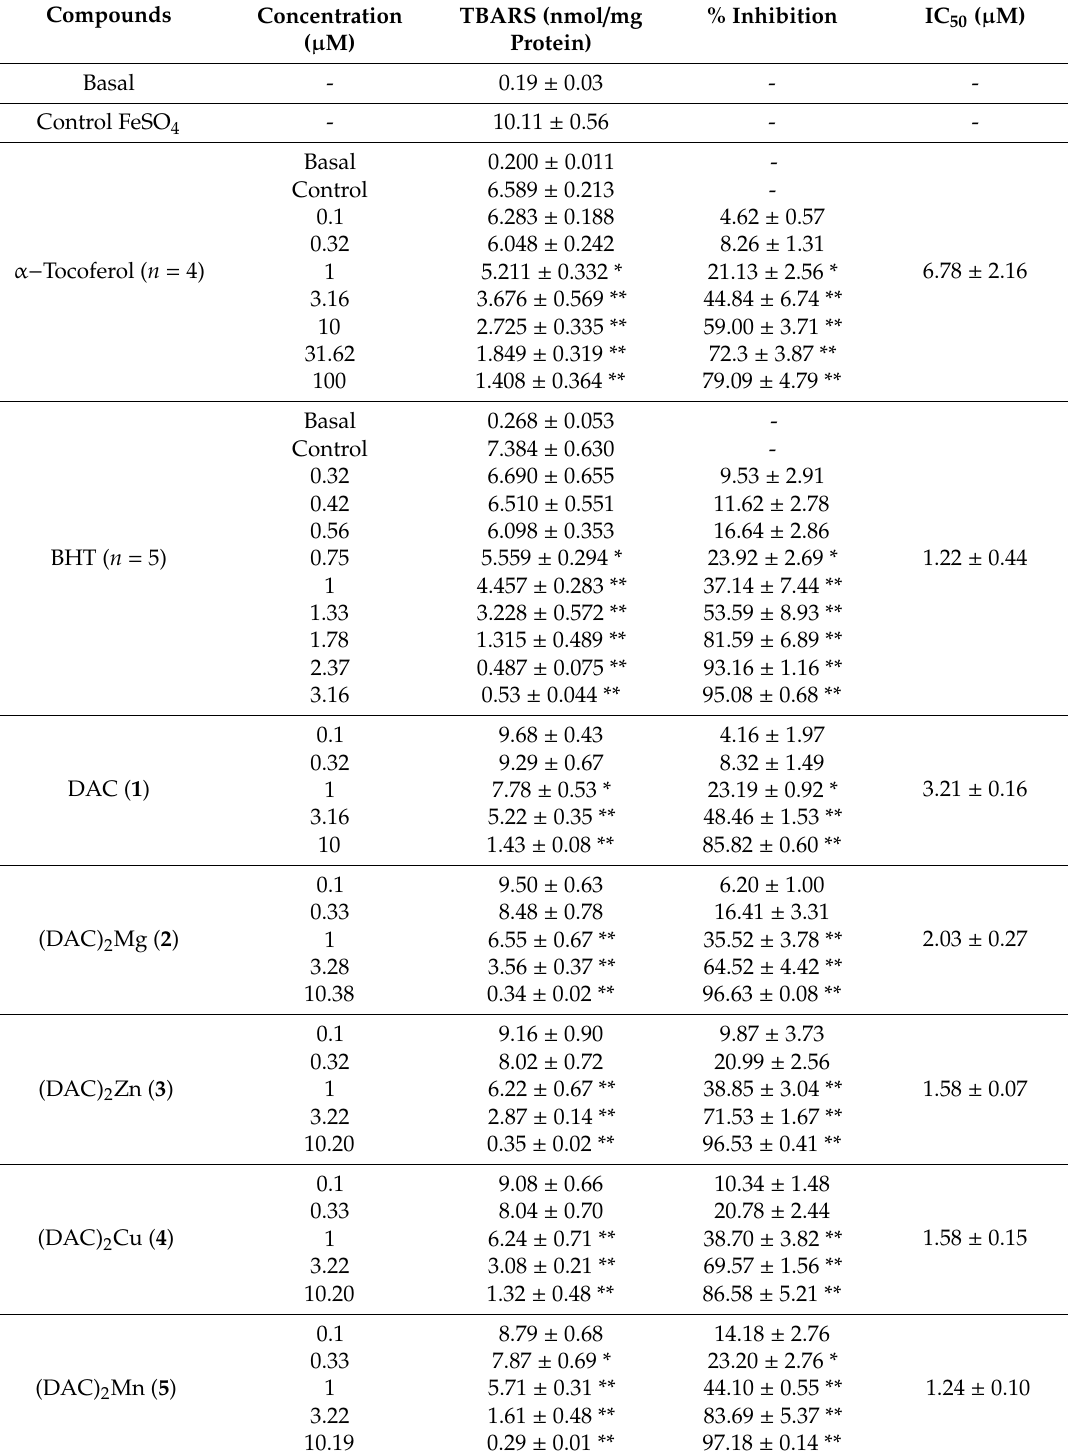
Table 8. IC 50 of inhibition of lipid peroxidation of compounds 1 , 2 , 3 , 4, and 5 . Compounds Concentration TBARS (nmol / mg % Inhibition IC 50 ( µ M) ( µ M) Protein) Basal - 0.19 ± 0.03 - - Control FeSO 4 - 10.11 ± 0.56 - - Basal